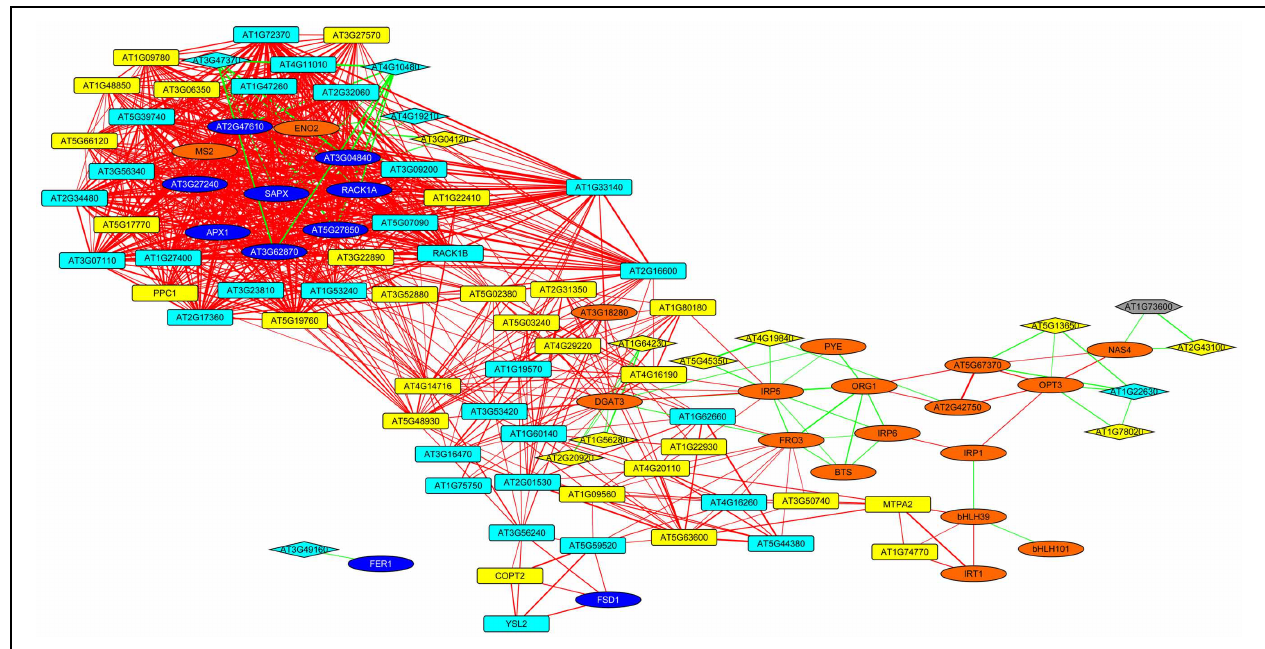
Light blue nodes denote genes that were down-regulated in roots or shoots, dark blue nodes indicate genes with decreased expression in both organs. Red and green lines represent co-expression edges derived from the root or leaf networks, respectively. Squared and diamond shaped nodes represent genes differentially expressed in roots and leaves,